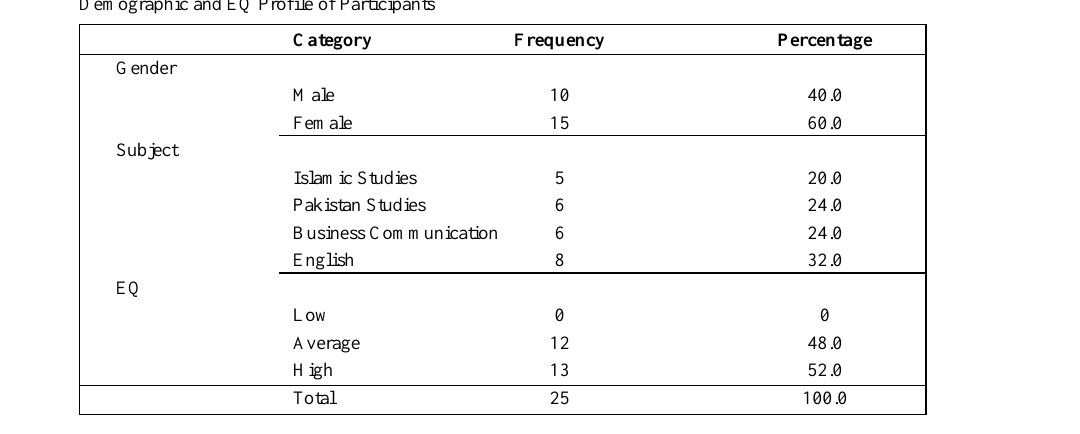
Table 1 Demographic and EQ Profile of Participants